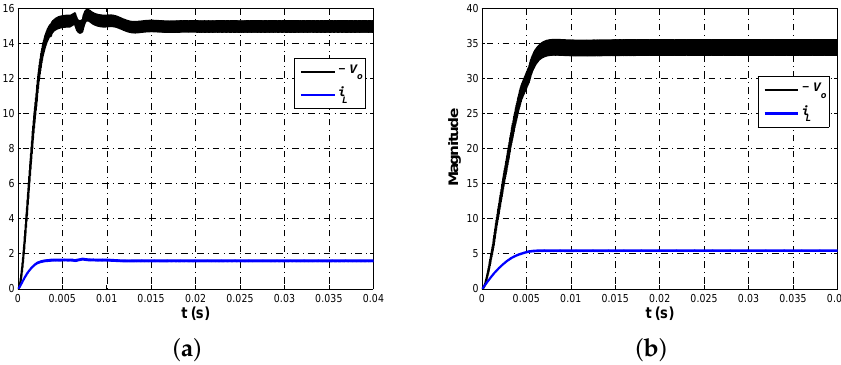
Figure 10. Regulated output voltage V o and inductor current i L of converter in Figure 1 for ( a ) buck and ( b ) boost conversion modes.